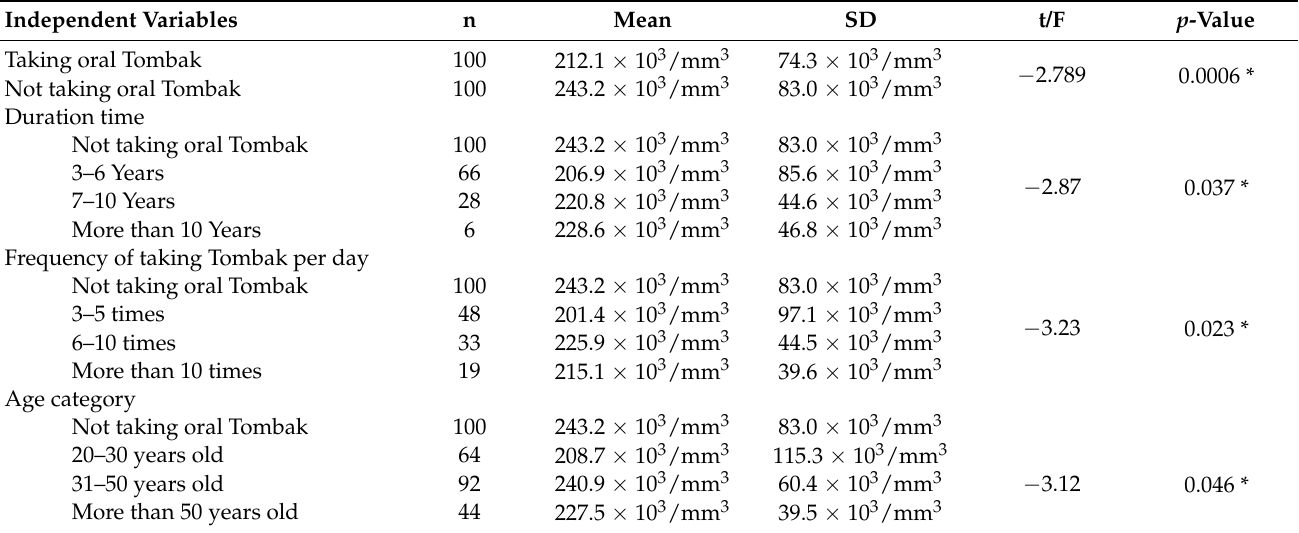
Table 1. The effects of taking oral Tombak on platelet counts among the study